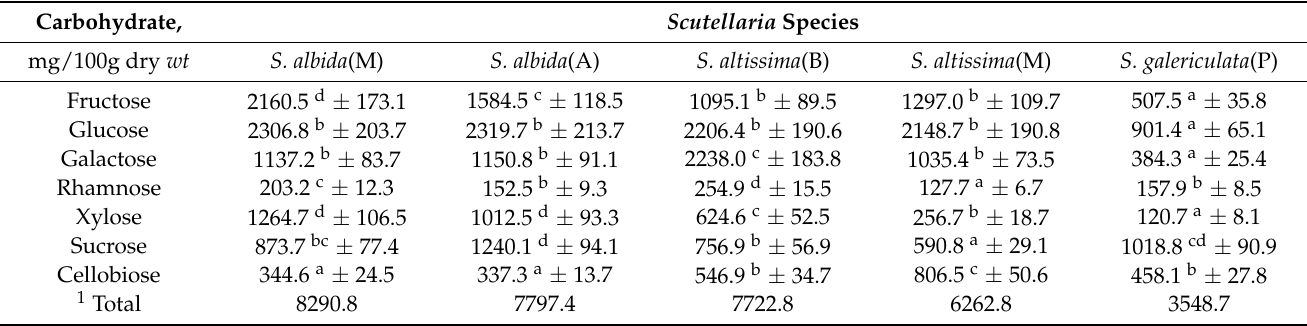
Table 2. Content of Carbohydrates in Scutellaria Species.